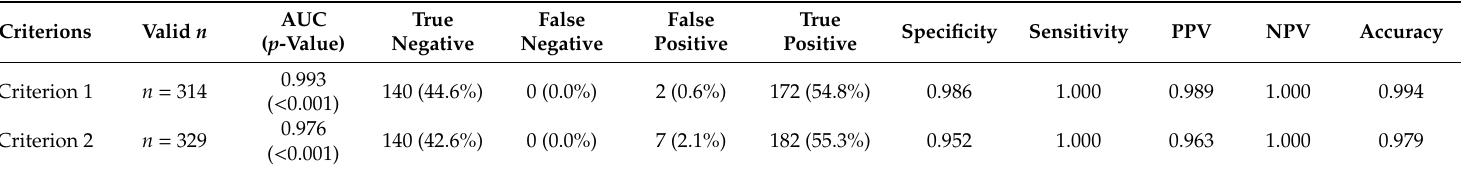
Table 4. Predictive power of diagnostic test combinations.